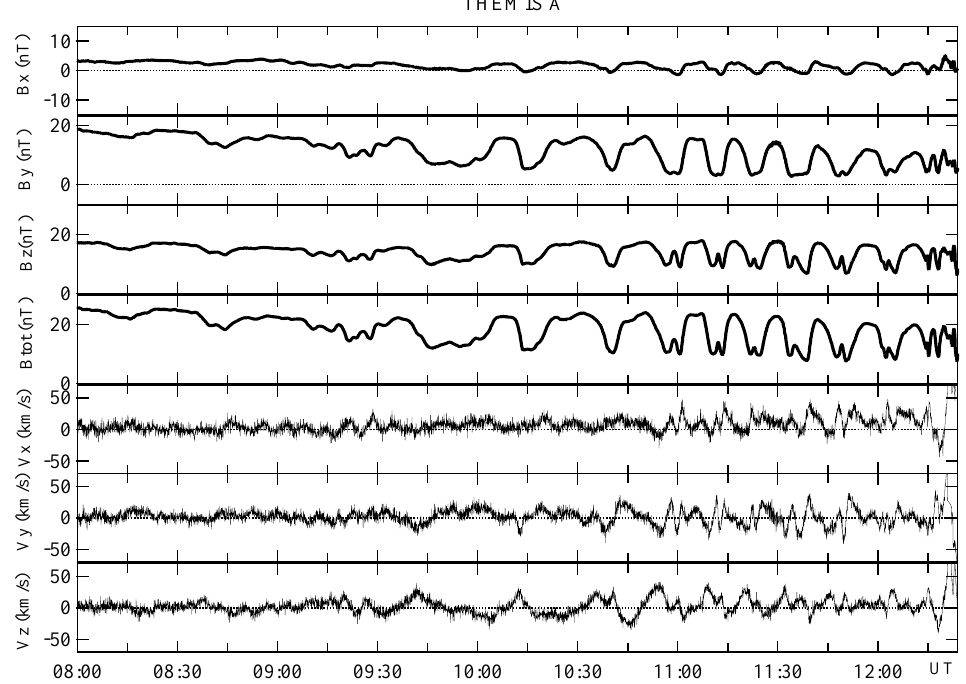
Fig. 3. THEMIS-A observations of the magnetic field and ion velocity from 08:00 to 12:24UT on 7 November 2007 in GSM